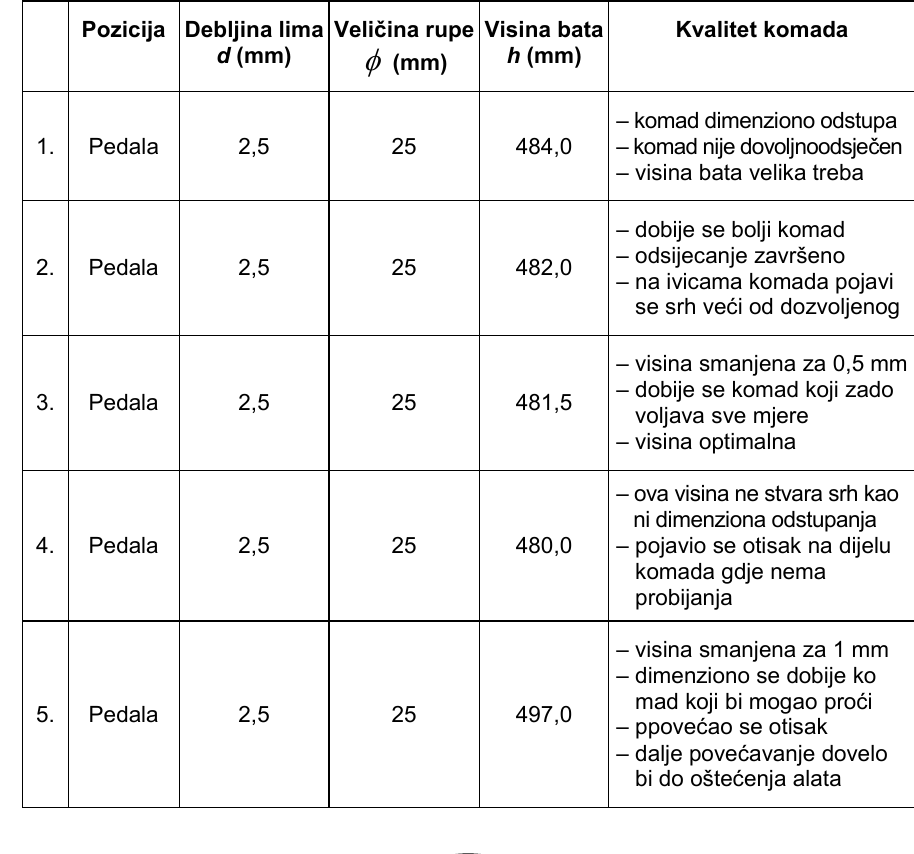
Table 2 – Experimental adjusting of the ram height for the “Pedala” position Pozicija Debljina